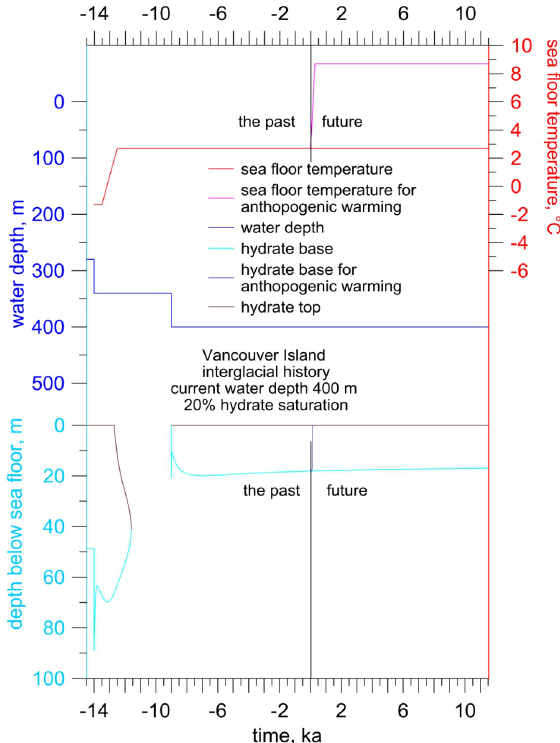
Figure 5. Marine GH model for the Vancouver Island offshore for 400 m present water depths for the interglacial − 13.5–11.5 kyrs both for the constant sea bottom 2.7 °C temperature and for a warming to 8.7 °C in the next 300